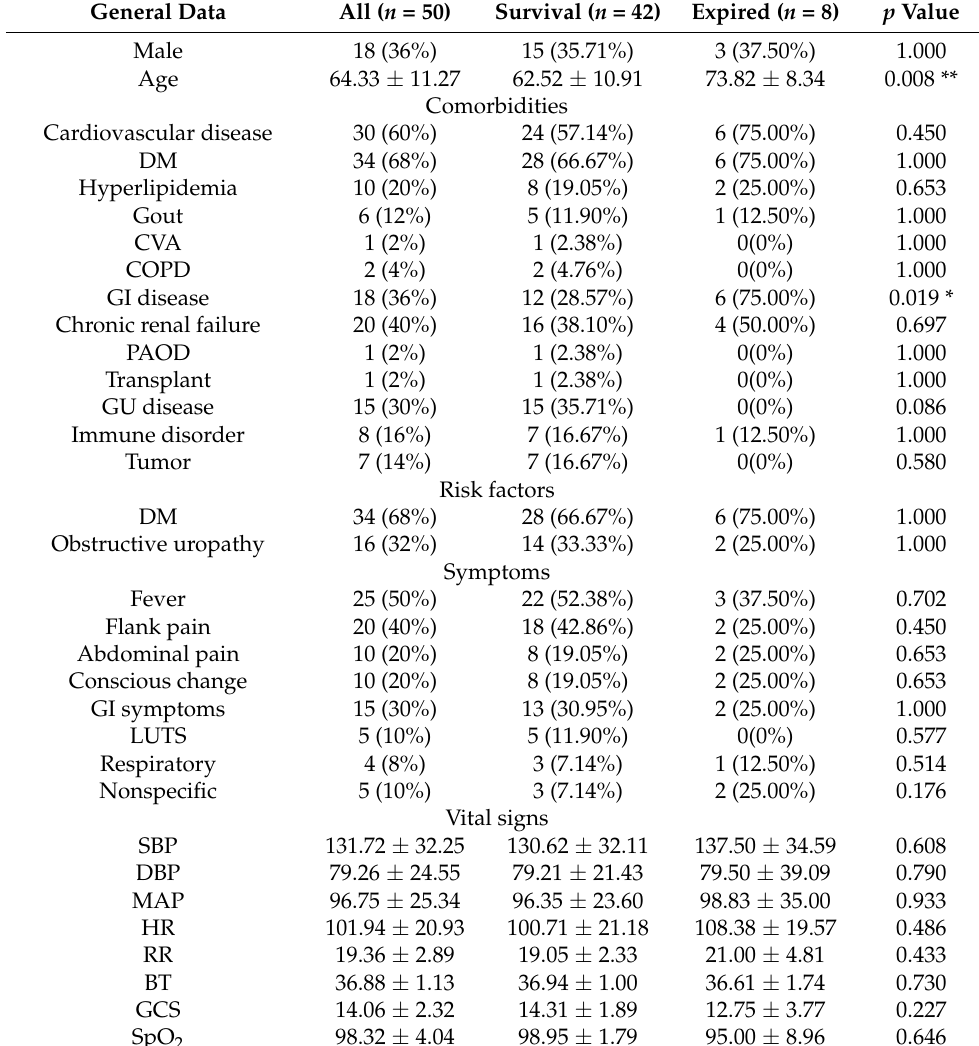
Table 1. Demographics and clinical characteristics of